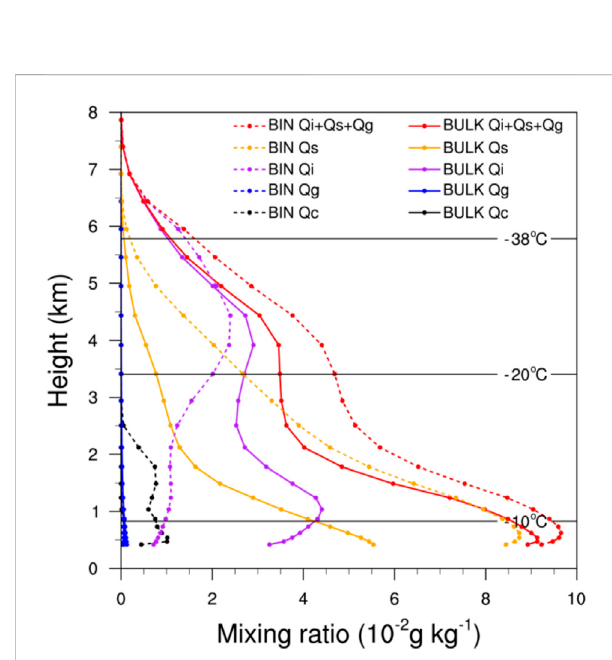
FIGURE 11 Average vertical pro fi les of the mixing ratio (unit: 10 – 2 g kg − 1 ) for cloud hydrometeors from 2000 UTC on February 12 to 1600 UTC on February 13, 2022, for the BULK and BIN